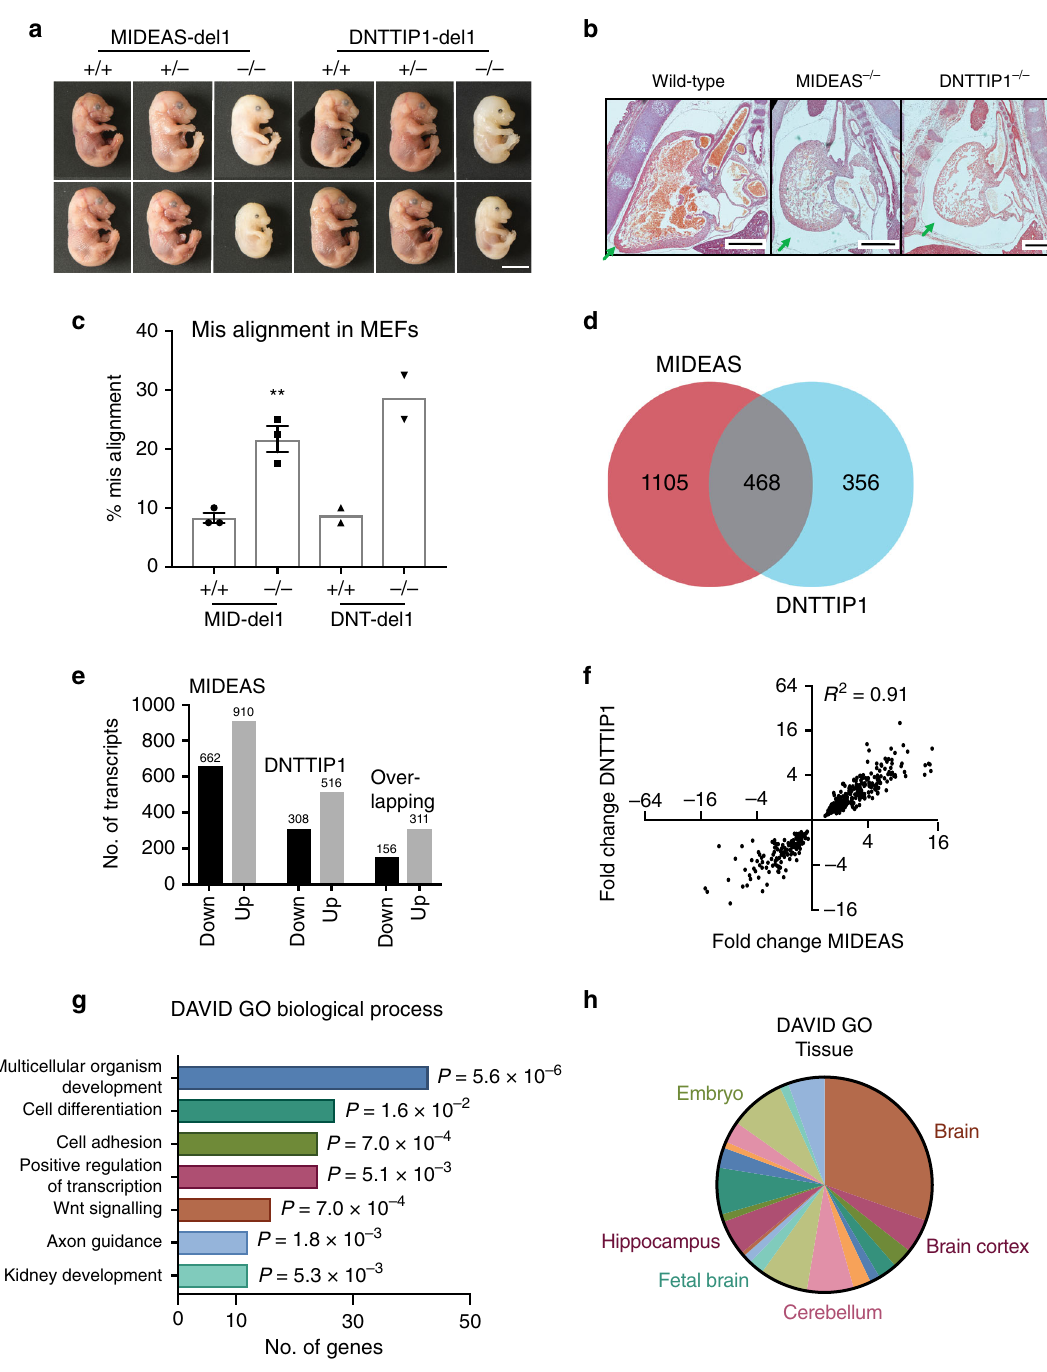
Fig. 3 Analysis of mice embryos and MEF ’ s lacking MIDEAS or DNTTIP1. a Images of wild-type, heterozygous and homozygous MIDEAS-del1